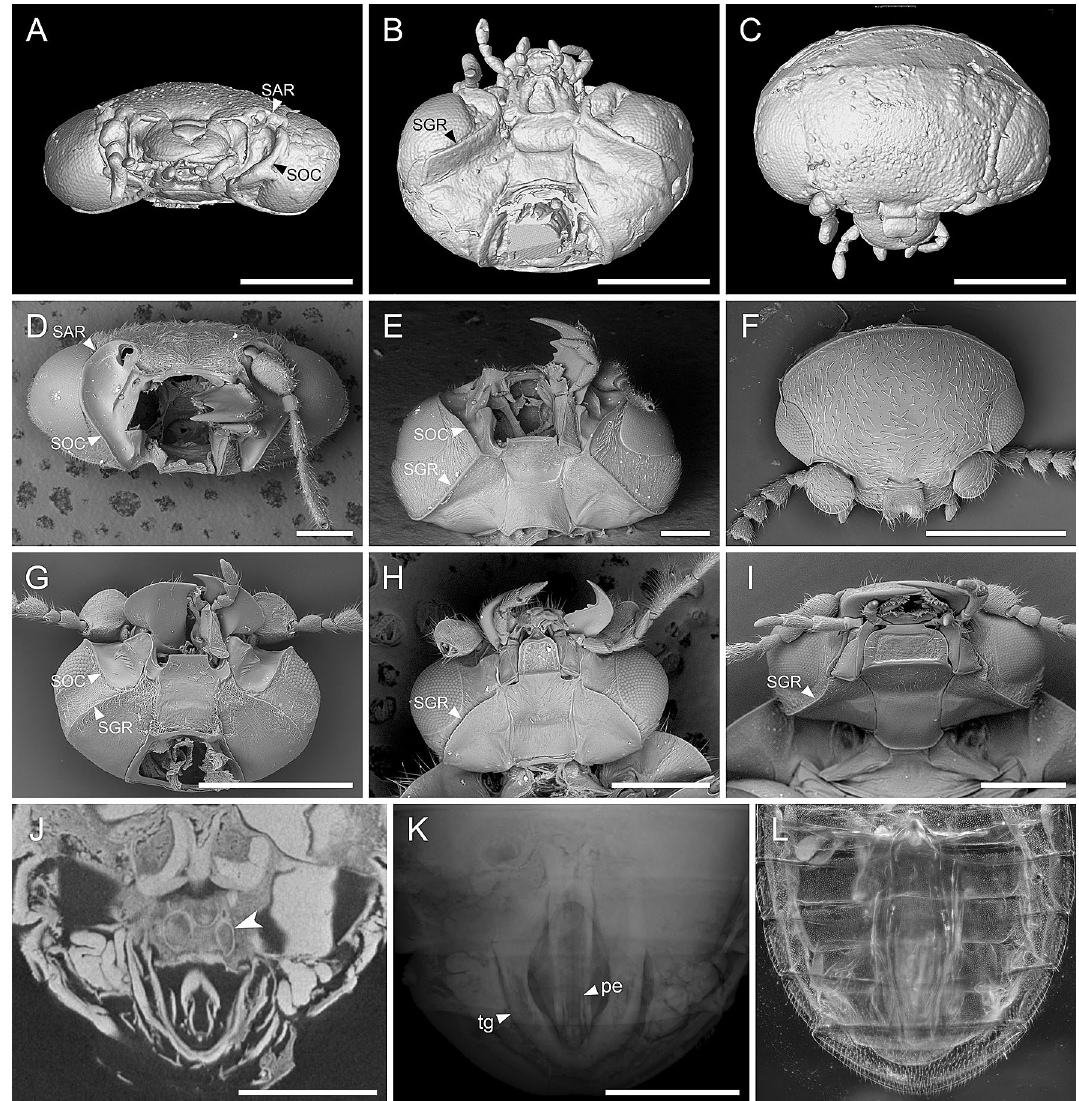
Figure 4. Comparison between Varcalium lawrencei gen. et sp. nov. and its extant relatives. ( A – C ) Varcalium lawrencei gen. et sp. nov. , head, mirrored, with antennae (partly) removed. ( D , E ) Byrrhopsis sp., head, with antennae and mouthparts (partly) removed. ( F , G ) Perplexacara latusmandibulara , head. ( H ) Prionocyphon ornatus , head. ( I ) Macrohelodes sp., head. ( J , K ) Varcalium lawrencei gen. et sp. nov. , aedeagus inside the abdomen, horizontal section (J) or “Sum along Ray” rendering (K), with arrowhead showing the cuticular rings ( J ). ( L ) Perplexacara latusmandibulara , aedeagus inside the abdomen. Abbreviations: SAR, supraantennal ridge; SGR, subgenal ridg; SOC, subocular carina; pe, penis; tg, tegmen. Scale bars: 500 a frontoclypeal suture, unidentate mandibles, and tibiae with paired longitudinal carinae (Fig. 2C, F). Within Scirtinae, several genera ( Exochomoscirtes Pic, Ora Clark, and Scirtes Illiger) with very thick hind femora for jumping form a distinct and well-supported clade 29 . Varcalium is excluded from this group by the lack of thick- ened hind femora (Fig. 2F). Ridges on head are important characters in scirtid taxonomy (Fig. 4). In the majority of scirtid genera, the supraantennal ridge (SAR) is short, and ends where it meets the medial edge of the eye, and therefore the supraantennal ridge and subgenal ridge (SGR) are not connected (e.g., Fig. 4H, I 48 ). In some other scirtids (e.g., Atopida White, Byrrhopsis Champion, Calvarium , Mucronotus Ruta, Pachycyphon Zwick 49–52 ), the supraanten- nal ridge turns ventrally in front of eye and becomes the subocular carina (SOC). This subocular carina usually connects the supraantennal ridge with the subgenal ridge, and acts as the outer edge of the subantennal groove (sulcus) in some genera (Fig. 4D–G). In Varcalium , the supraantennal ridge smoothly turns ventrally to become the subocular carina, and then again smoothly turns outwards to become the subgenal ridge (Fig. 4A–C). Thus, Varcalium is likely related to those extant genera possessing subocular carina. The phylogenetic analysis also supports a close relationship for the genera with subocular carina (Fig. 5). All genera coded in the analysis with subocular carina, except for Cyphanus Sharp, form a monophyletic group ( Veronatus Sharp, Varcalium ,